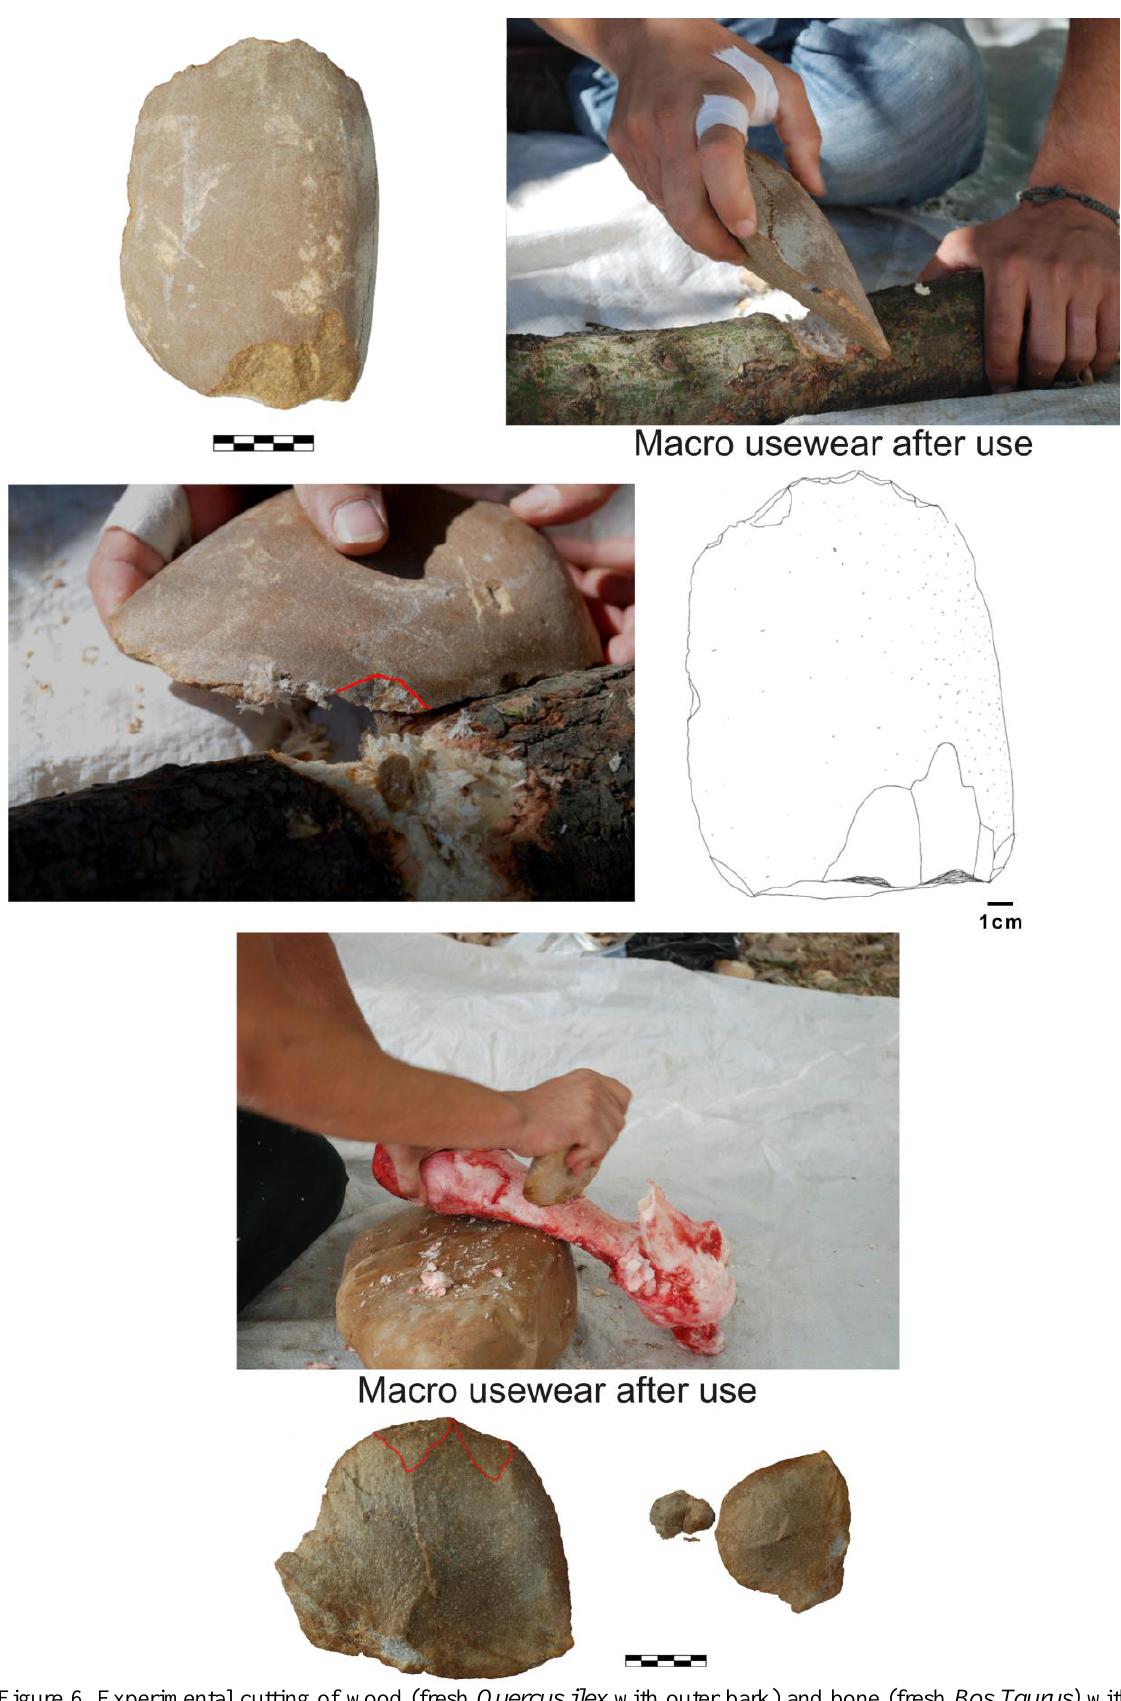
Figure 6. Experimental cutting of wood (fresh Quercus ilex with outer bark) and bone (fresh Bos Taurus) with cortical